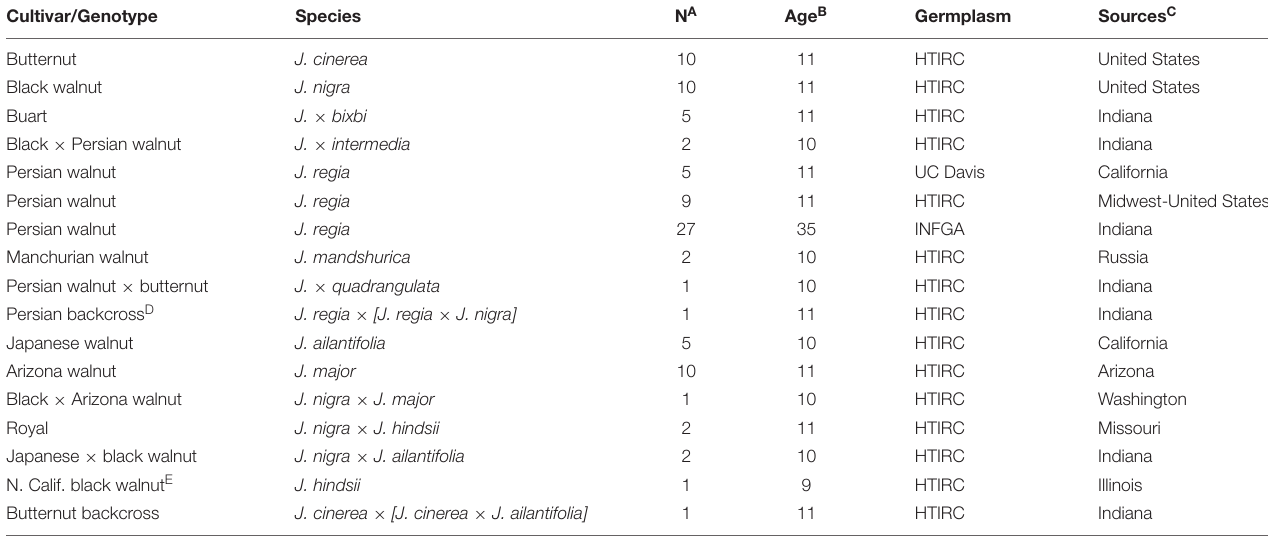
TABLE 1 | List of Juglans and hybrid genotypes used in this study. Cultivar/Genotype